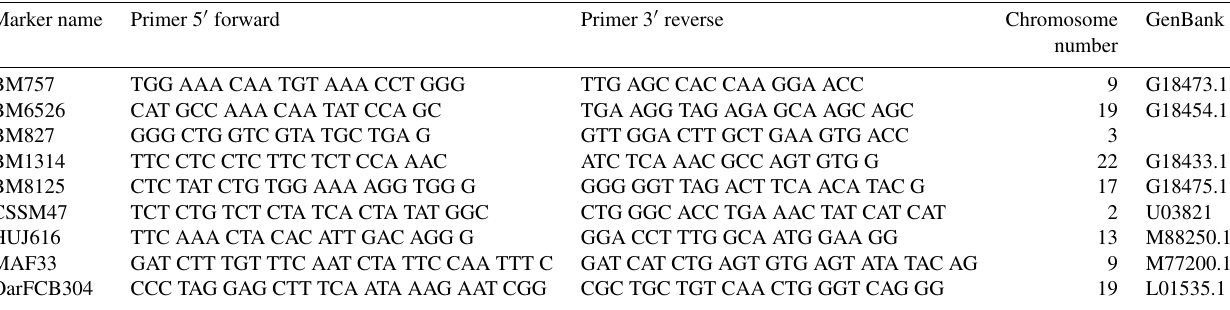
Table 1. Microsatellite marker names, primer sequences, chromosome and GenBank accession